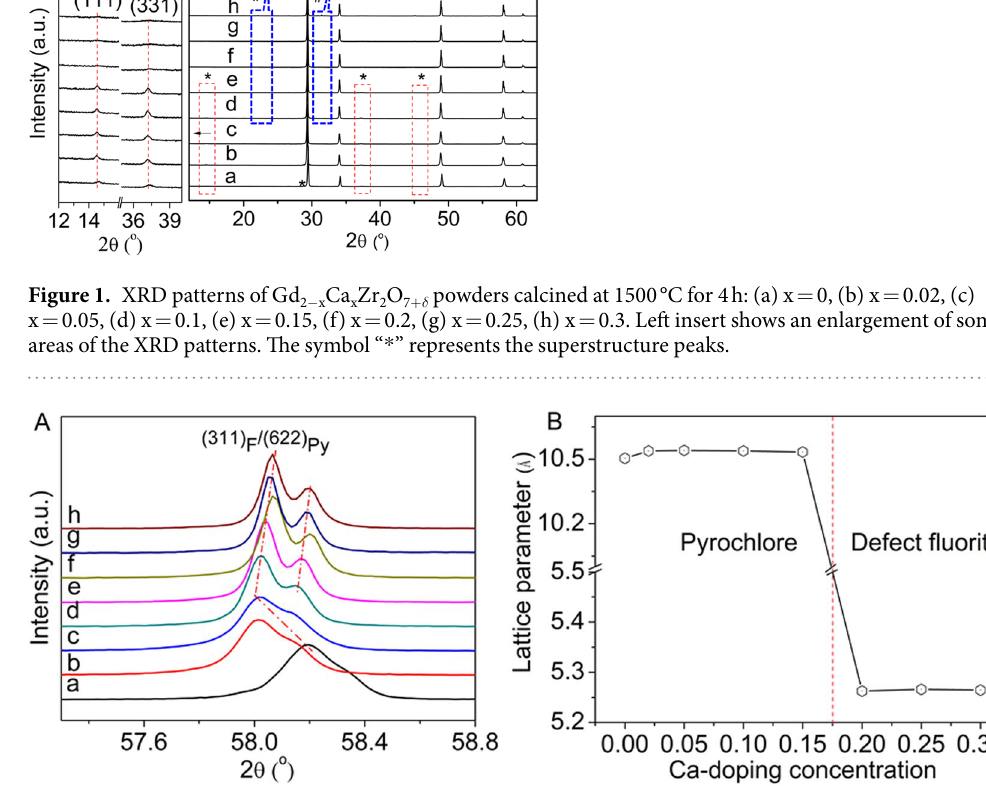
Figure 2. ( A ) (311) F /(622) Py peak of Gd 2 − x Ca x Zr 2 O 7 +δ samples in 2 θ range of 56.5–57.5°:(a) x = 0, (b) x = 0.02, (c) x = 0.05, (d) x = 0.1, (e) x = 0.15, (f) x = 0.2, (g) x = 0.25, (h) x = 0.3; ( B ) Lattice parameters of Gd 2 − x Ca x Zr 2 O 7 + δ in different phase